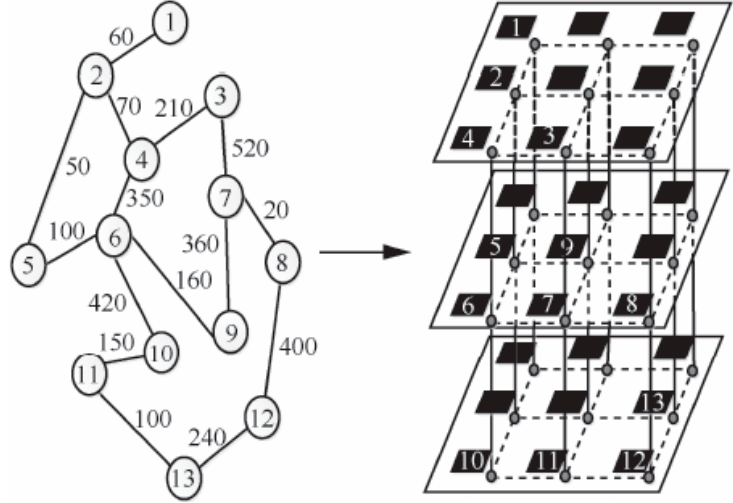
Figure 2. 3D NoC mapping.